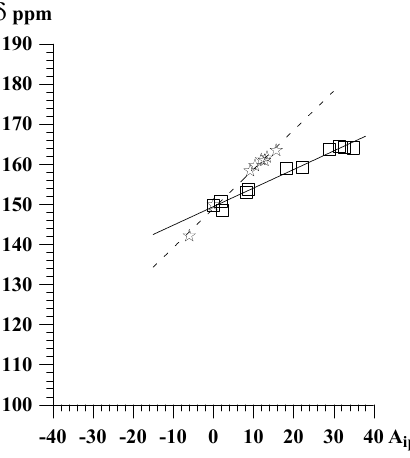
Figure 2 . Correlation of chemical shifts of carbon atoms bonded to a substituent in 2-substituted pyridine derivatives with the A parameters i (cid:156) - bulky substituents (cid:133) - other